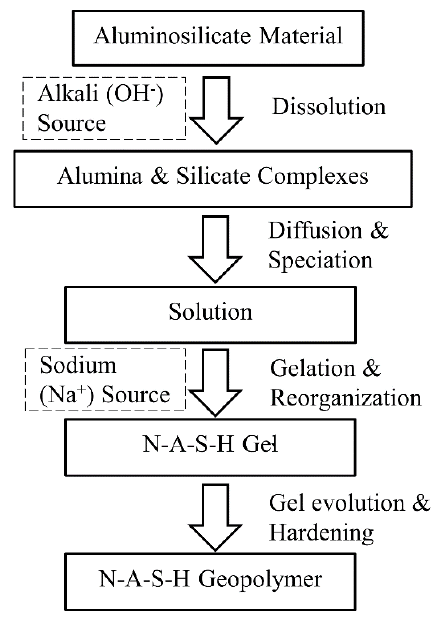
Figure 1. Schematic diagram of the Sodium Aluminate Silicate Hydrate (N-A-S-H) geopolymer model.